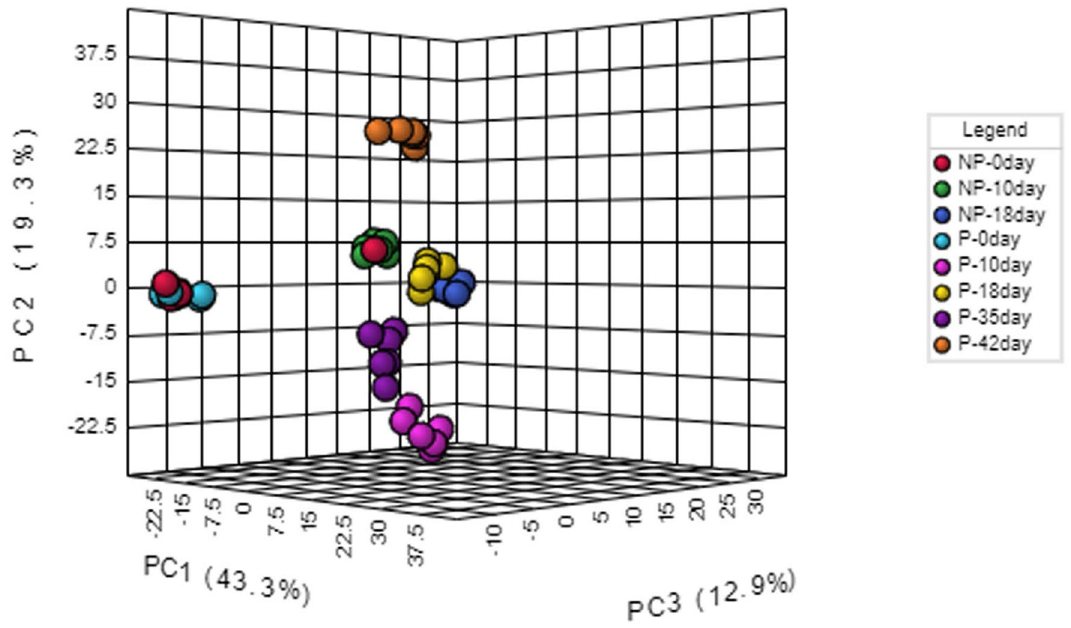
Figure 1. Principal component analysis (PCA) of the five principal components PC1 (43.3%), PC2 (19.3%), PC3 (12.9%), PC4 (9.6%) and PC5 (5.8%) revealing the overall metabolic differences between the pregnant and non-pregnant samples at different time-points (day 0, day 10, day 18, day 35 and day